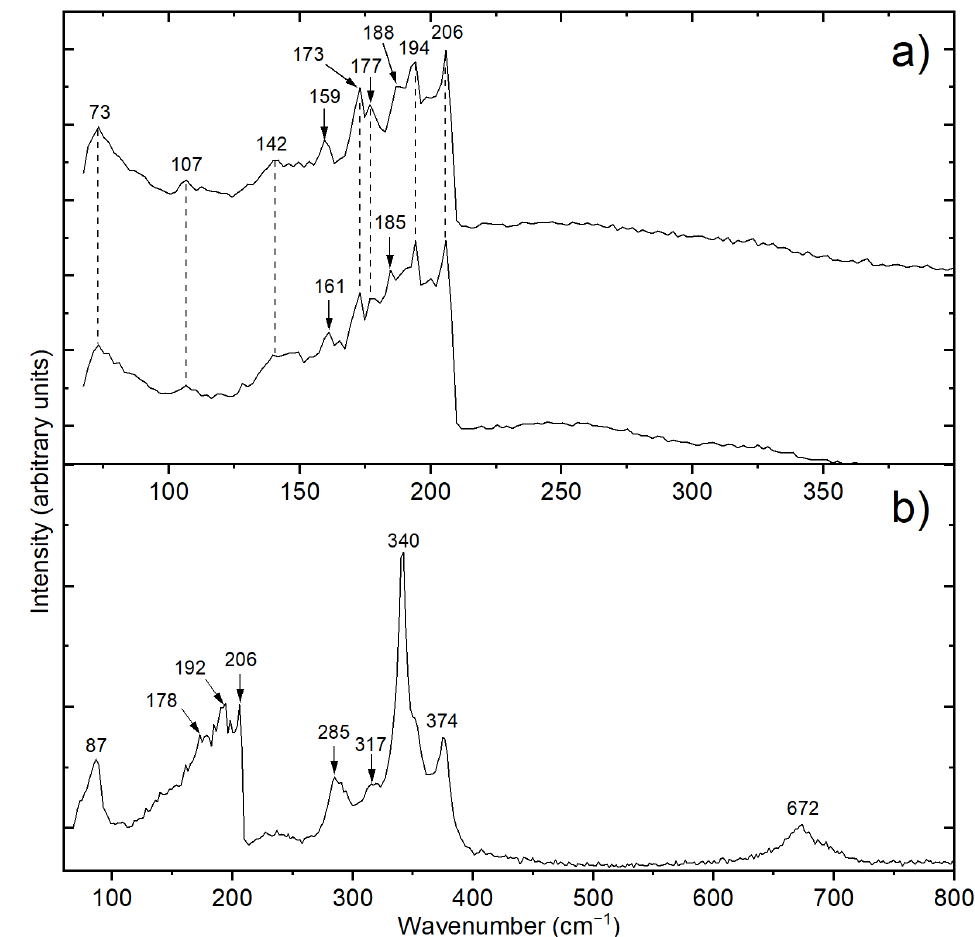
Figure 9. Selective Raman spectra of the unnamed mineral ( a ); the Raman spectrum of mawsonite ( b ).